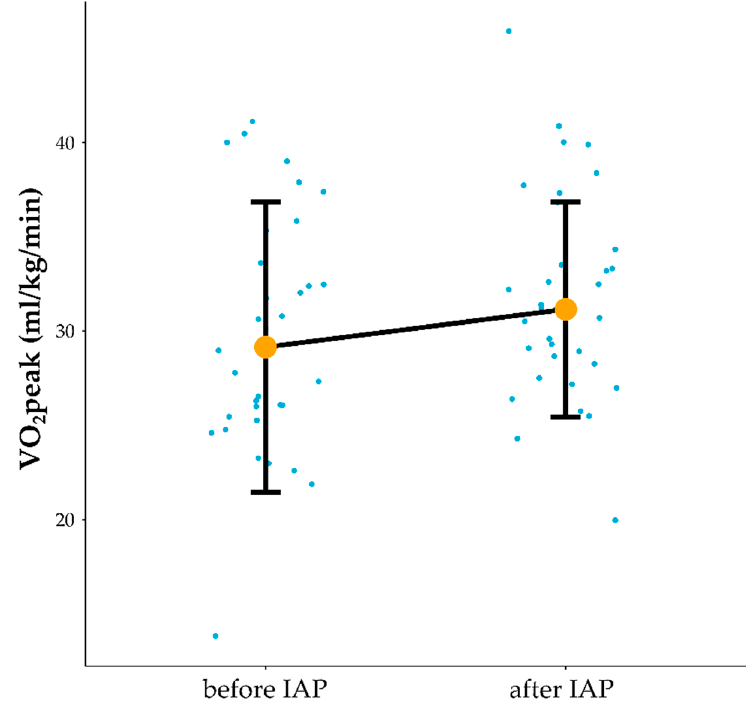
Figure 3. Influence of IAP on VO 2 peak. VO 2 peak mL/kg/min—maximal oxygen uptake during physical exercise measured in ml/kg/min, IAP—Individualised Activity Program, Orange dots connected by black line indicate median value, vertical black lines denote interquartile range. Blue dots before and after denote the results of individual patients.